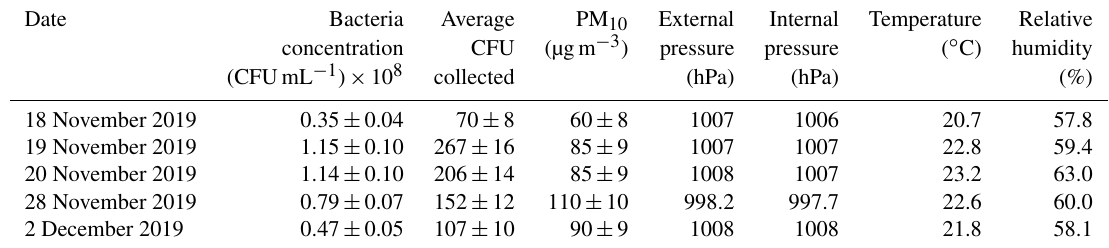
Table 3. Bacteria concentration in the aerosolized solution, average number of colonies counted on the petri dishes, and the meteorological parameters ( P , T , RH) in ChAMBRe in the experiments with the SLAG nebulizer operated at: liquid feed rate = 0.4mLmin − 1 , volume of